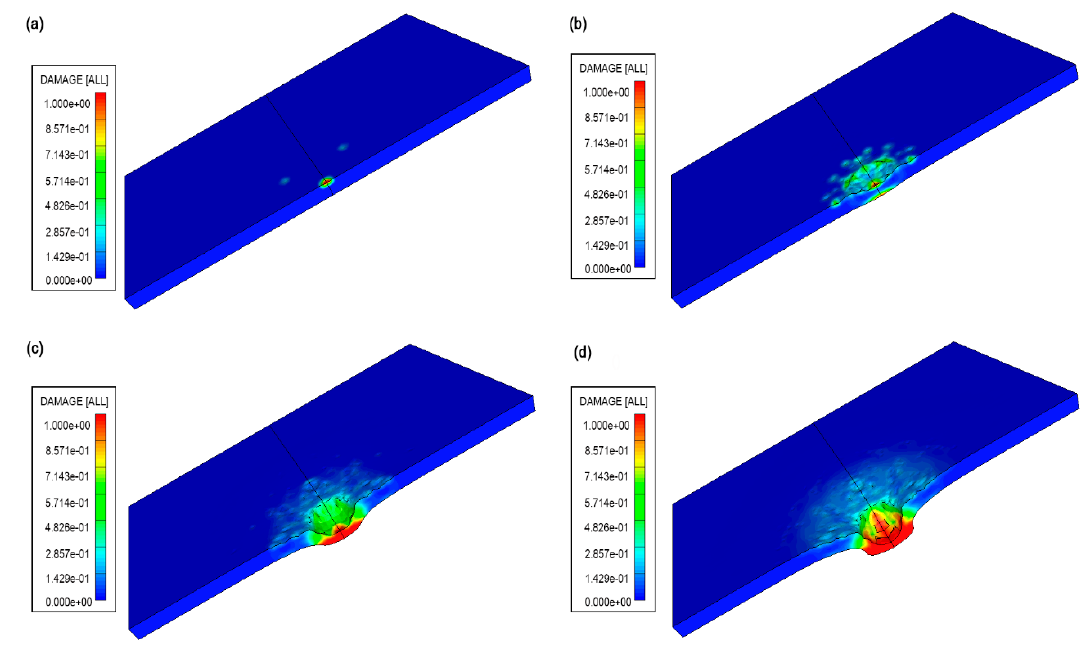
Figure 15. The damage contours of the rear plate in Configuration A-4 at different times after impact (( a ) t = 0 ms; ( b ) t = 0.01 ms; ( c ) t = 0.02 ms; ( d ) t = 0.03 ms).